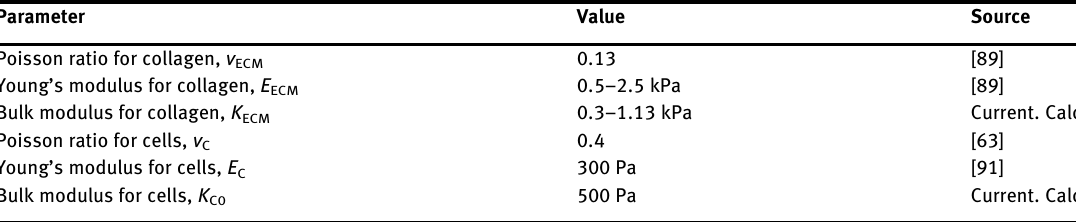
Table  : Rheological parameters.